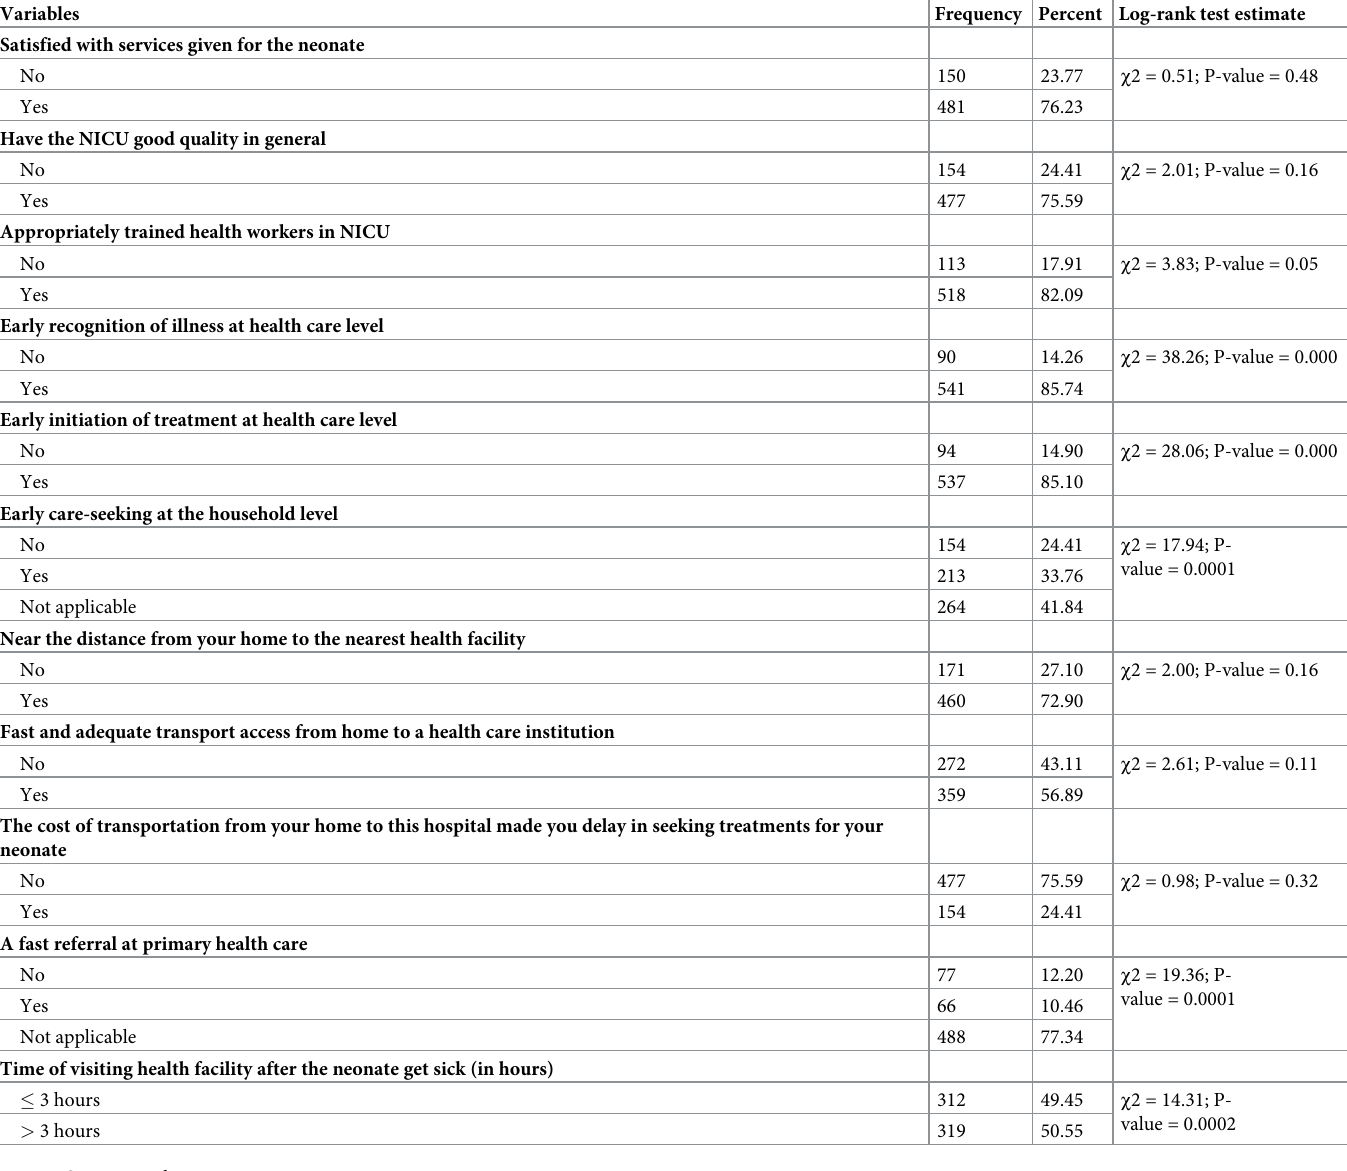
Table 5. Health care service-related characteristics in Public Hospitals of Central Gondar Zone, 2021 (n = 631).